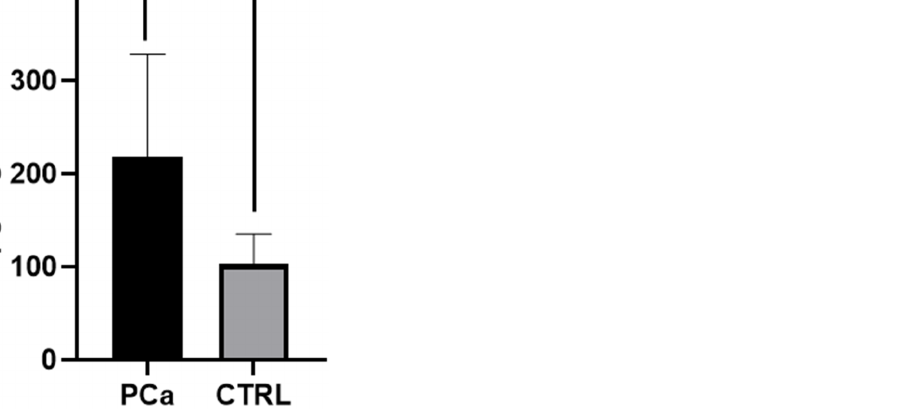
Figure 4. 8 ‐ Iso ‐ PGF2 α levels in PCa patients at T0 and CTRL. Levels of 8 ‐ Iso ‐ PGF2 α measured in urine from PCa patients (at T0) and CTRL subjects. Data are represented as means ± SD.